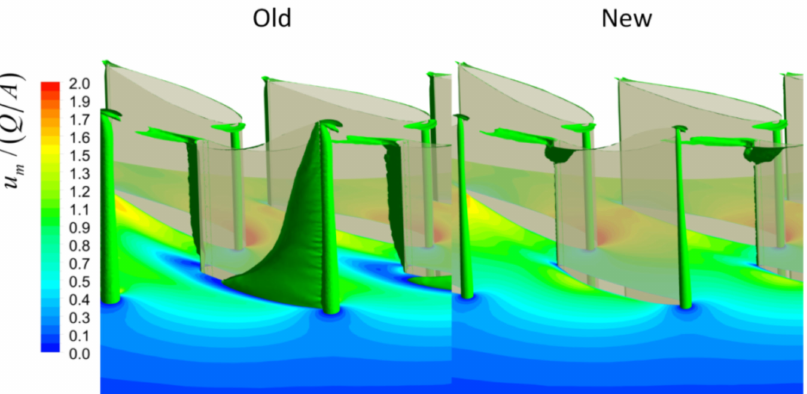
Figure 14. Flow velocity at the tandem cascade horizontal plane functions of the inlet area of the spiral case and the turbine discharge and u m = 0 isosurface in case 1 hydraulic turbine.